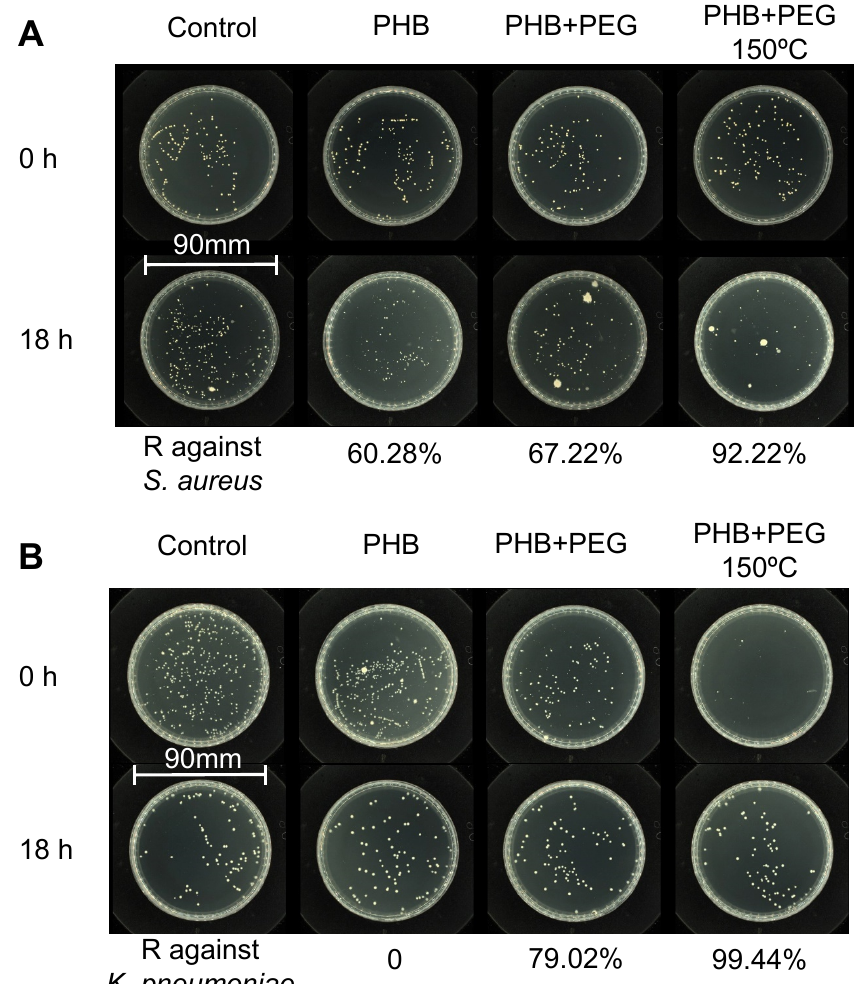
Figure 3. Antimicrobial test for PHB powder, mixture of PHB powder and PEG reacted under room temperature, and mixture of PHB powder and PEG reacted under 150 °C. ( A ) Antimicrobial test against S. aureus . ( B ) Antimicrobial test against K. pneumoniae .